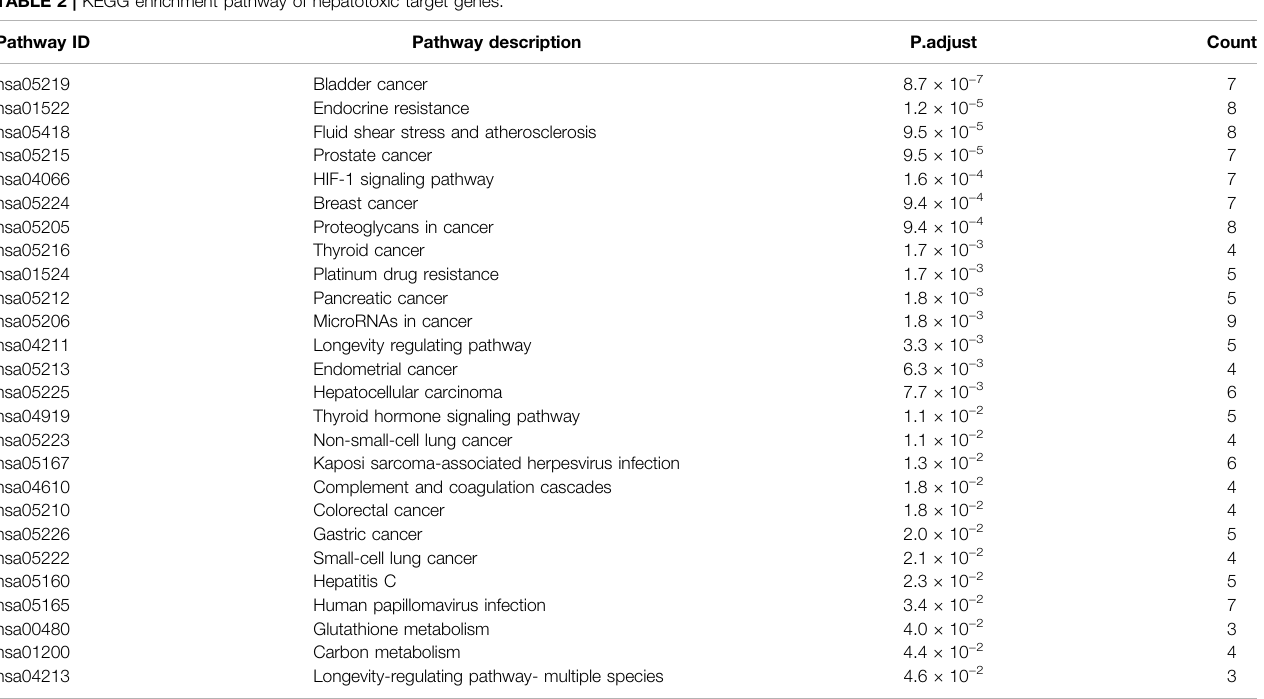
TABLE 2 | KEGG enrichment pathway of hepatotoxic target genes. Pathway ID Pathway description